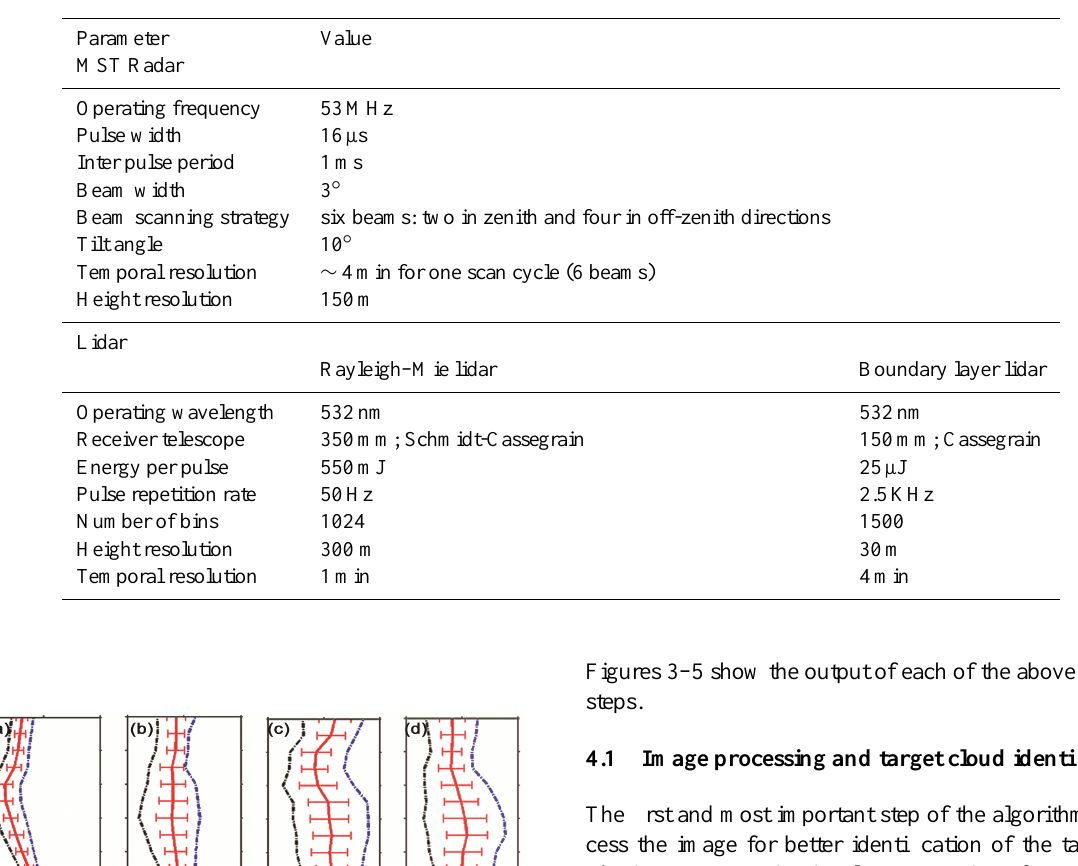
Table 1. Specifications of the MST radar and different lidars for routine operations.